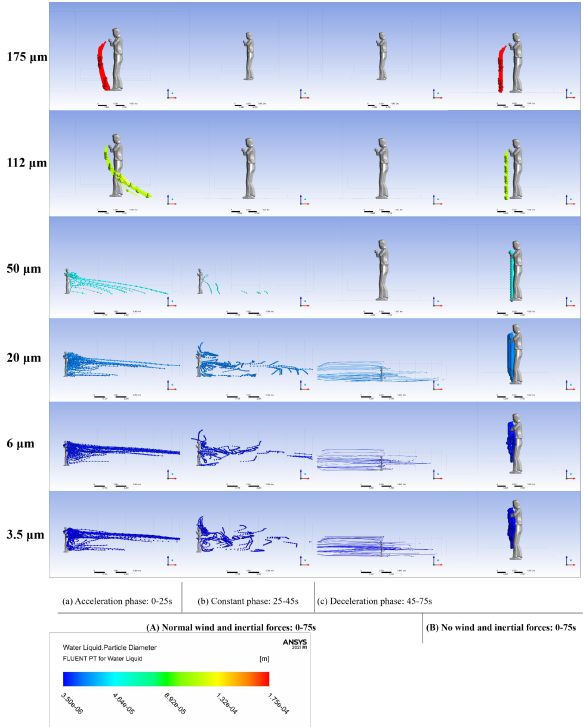
Figure 6 . The particle trajectory tracking chart of the normal wind and the no wind configurations. (A) Normal and inertial force effect during 0-75s; (B) No wind effect during 0-75s. (a), (b) and (c) are time-series graphs of six droplet sizes during three